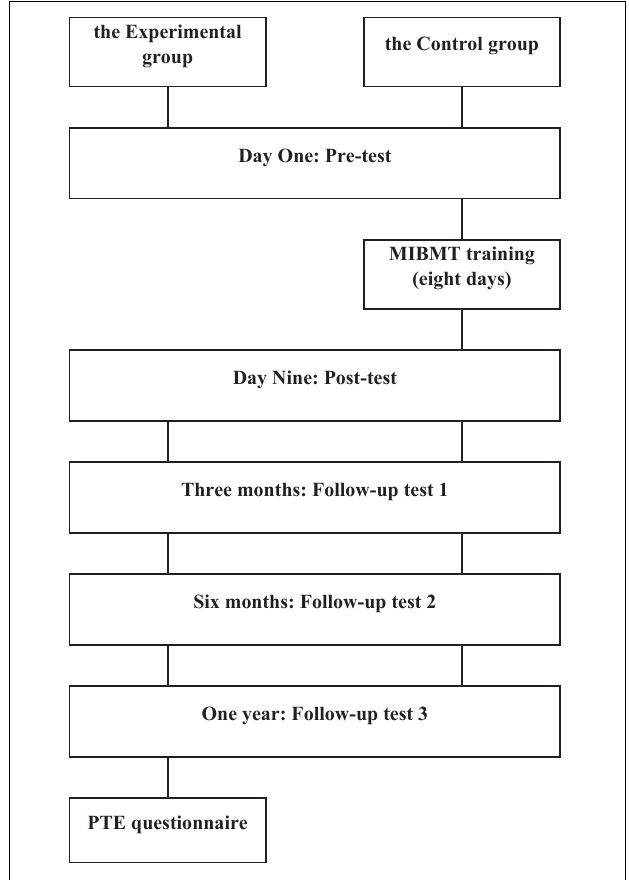
FIGURE 1 | The procedure of experiment 1. MIBMT, mental-imagery-based mnemonic training; PTE, post-training